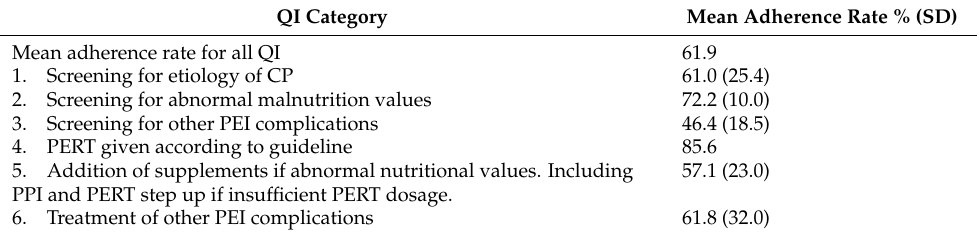
Table 2. Overall mean adherence rate and mean adherence to the six general categories of quality indicators.